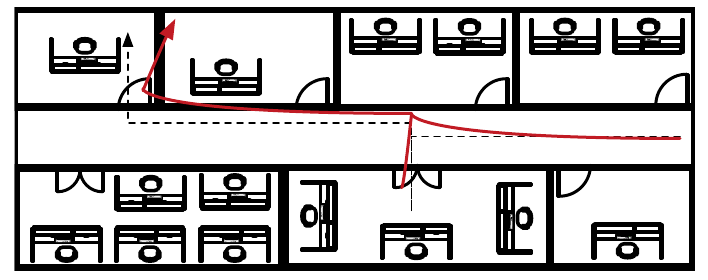
Figure 11. Inertial position estimation with drift (red) and corrected path